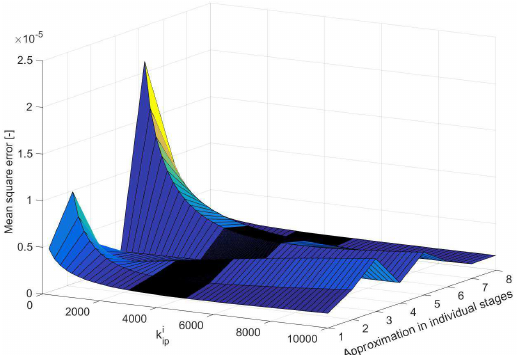
Figure 4. Residual sums of control functions with variable α i on the searched parametric space. m